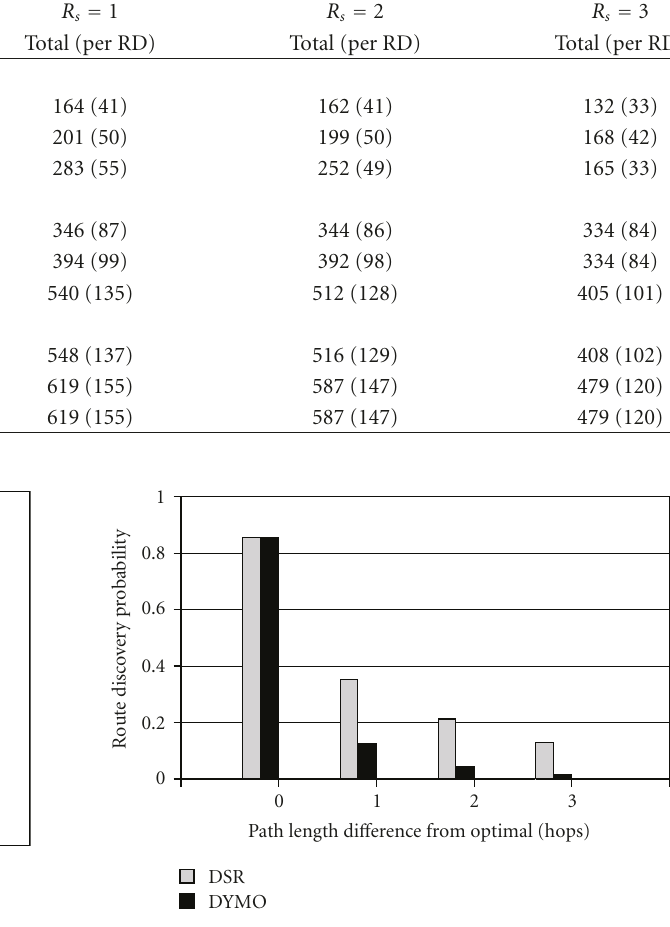
Figure 5: Route optimality of DYMO in mobile